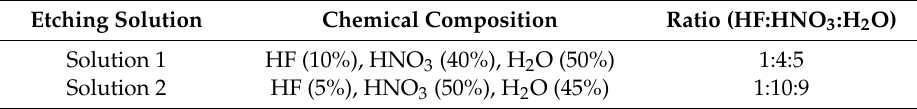
Table 3. The chemical composition of two etching solutions used for chemical